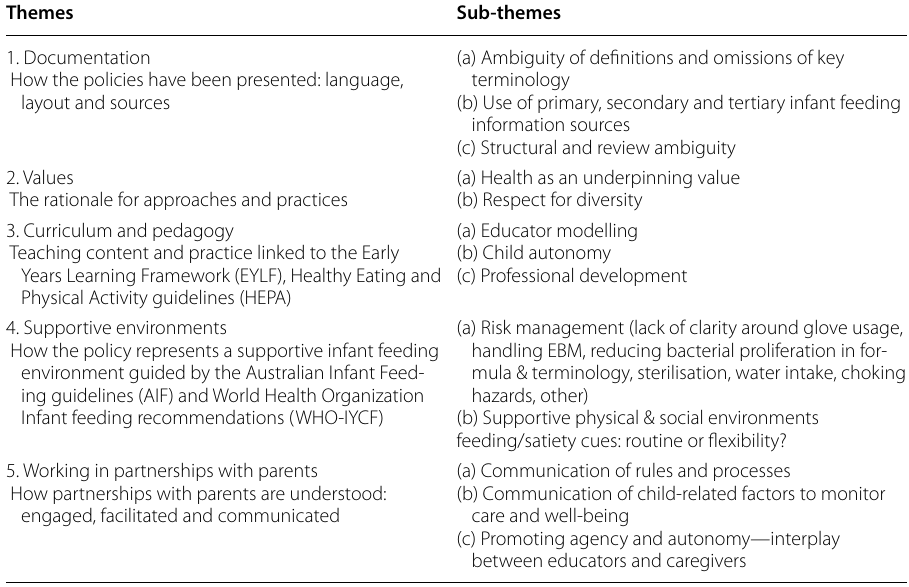
a FDC services include between 20 and 80 FDC sites and food provision varied between sites and within sites. Policies are developed for each service and so cover the sites within the service